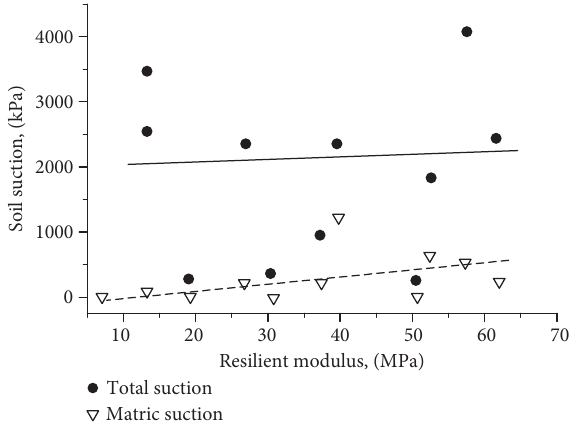
Figure 3: Illustration of the relationship between resilient modulus and matric suction for A-7-5 and A-7-6 soils ( σ d � 103kPa; � 21kPa) (from σ 3